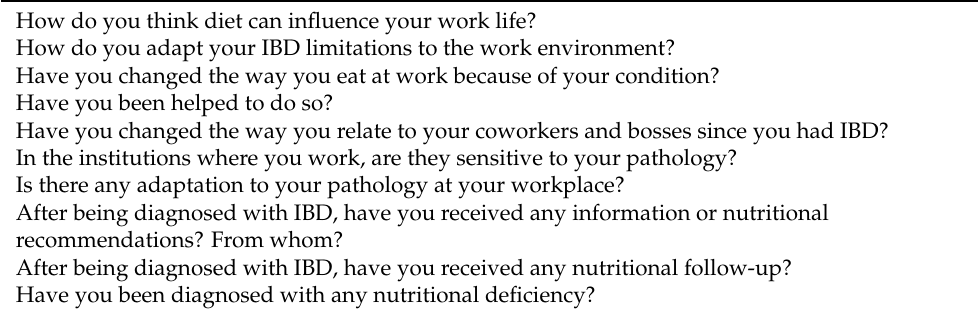
Table 2. The agreed questions for Focus Group